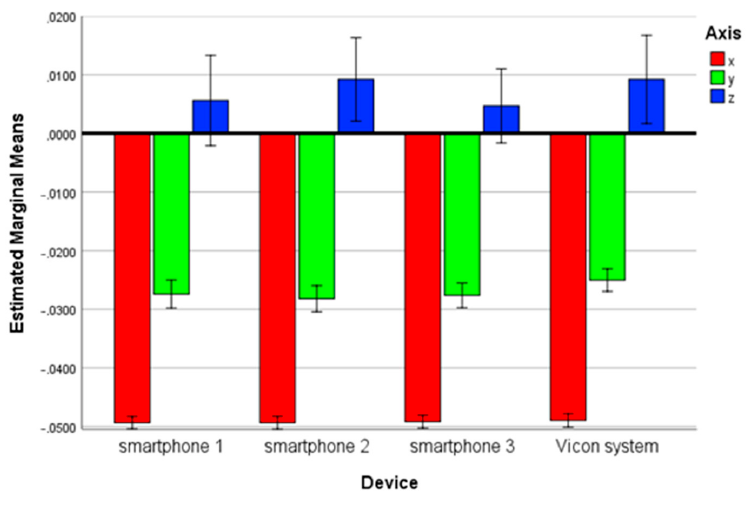
Figure 10. Estimated marginal means of the three-axis acceleration among the three smartphones and the Vicon